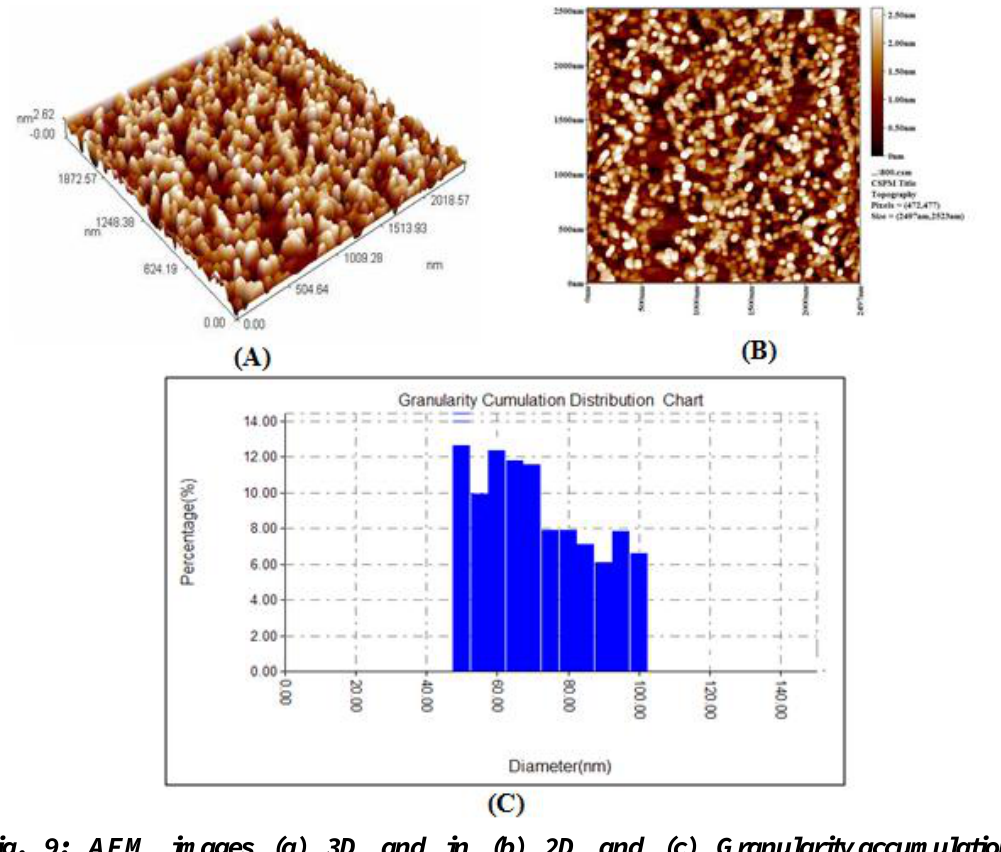
Fig. 9: AFM images (a) 3D and in (b) 2D and (c) Granularity accumulation distribution chart of the S3